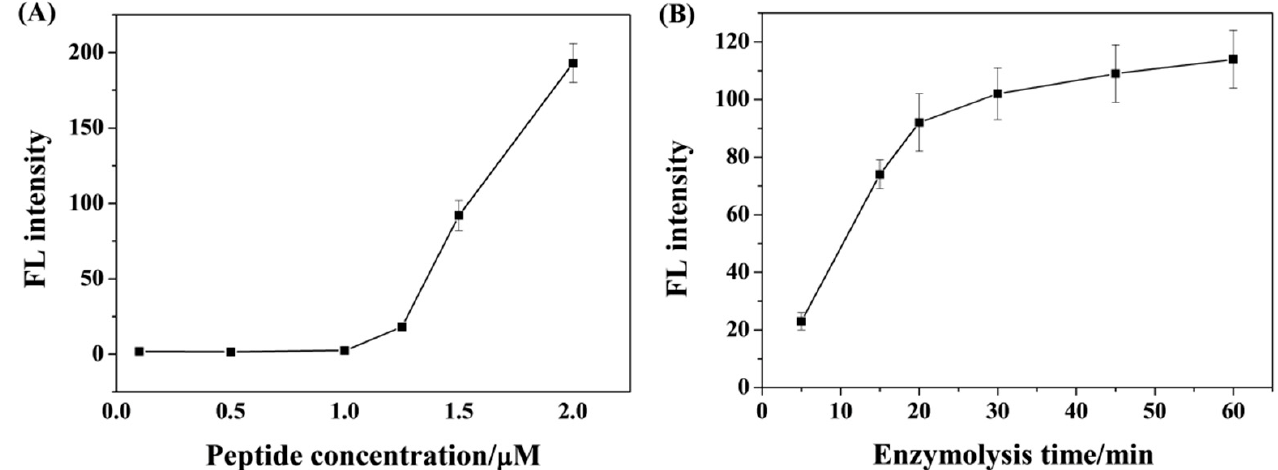
Figure 2. Dependence of fluorescence intensity on peptide concentration ( A ) and enzymolysis time ( B ).